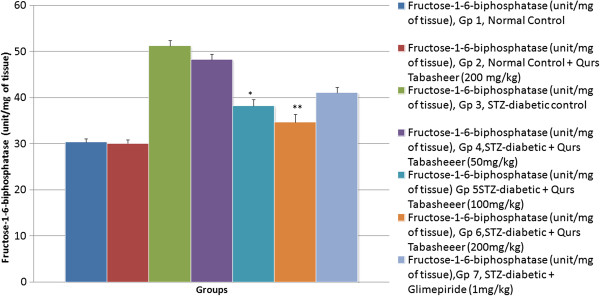
Effect of Qurs Tabasheer on level of fructose-1-6-biphosphatase at different concentrations on normal and STZ induced diabetic rats, compared to standard drug Glimepiride; values are mean ± SEM; n = 6; *P < 0.05; **P < 0.01; ***P < 0.001; P > 0.05 is considered as non-significant (ns).